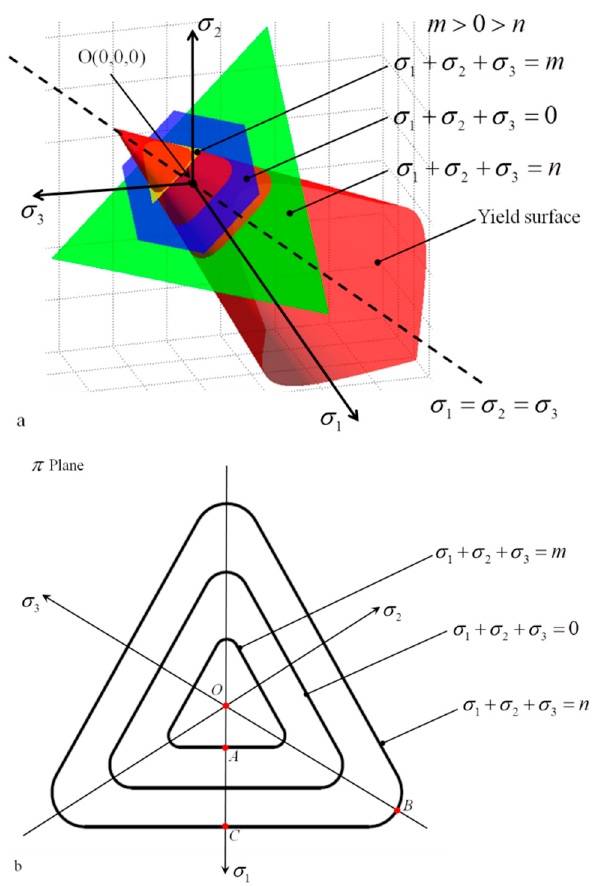
π plane ( b ). Figure 3. Yield surface in 3–dimension principal stress space ( a ) and π plane ( b